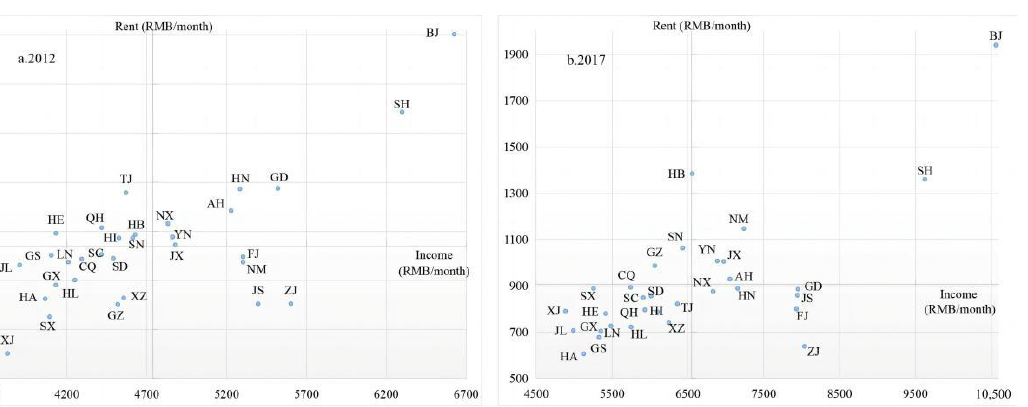
Figure 3. Rent and income of floating population by province, 2012 and 2017.